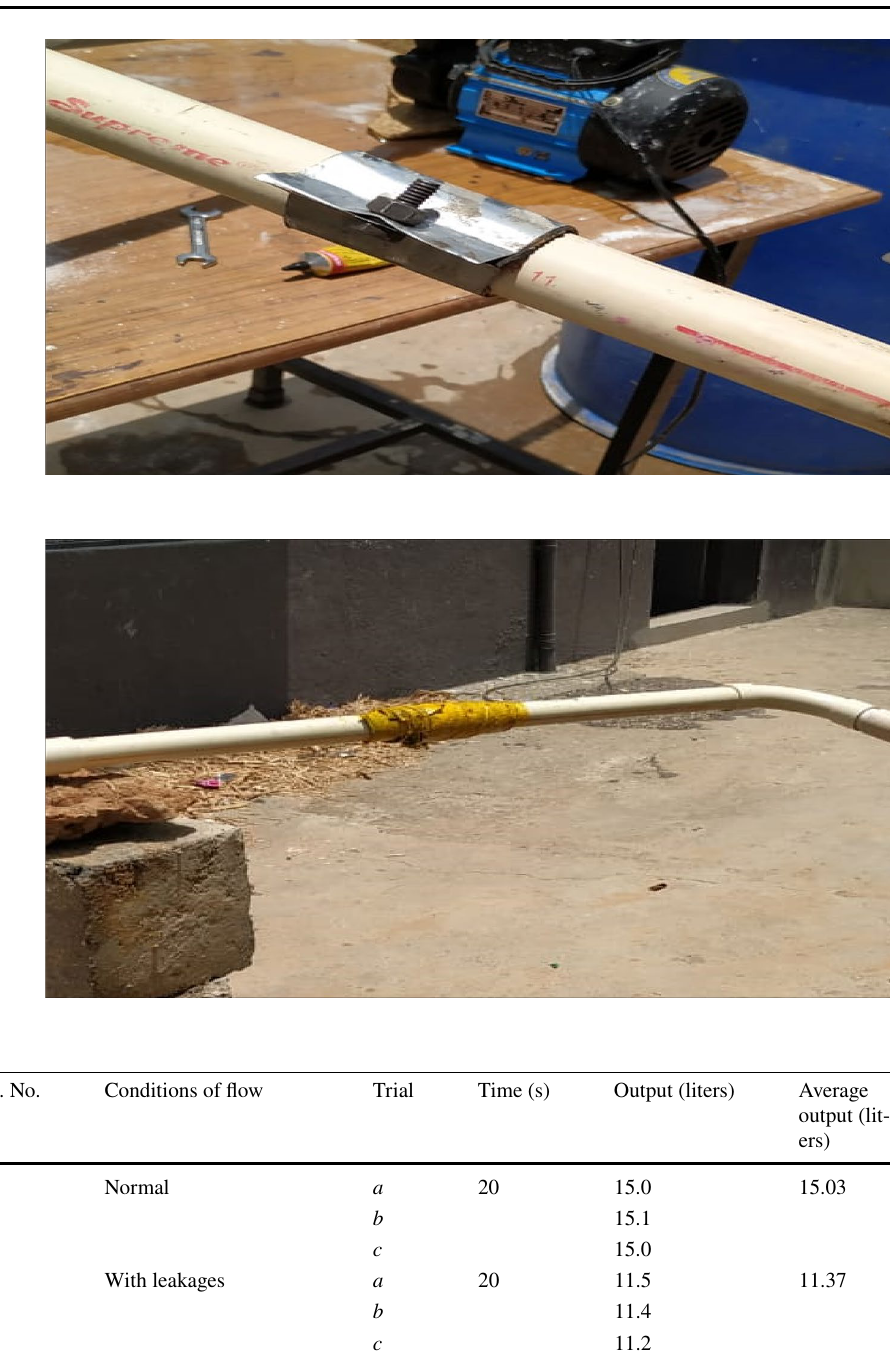
Table 2 Data of water losses under different condition obtained from experiment